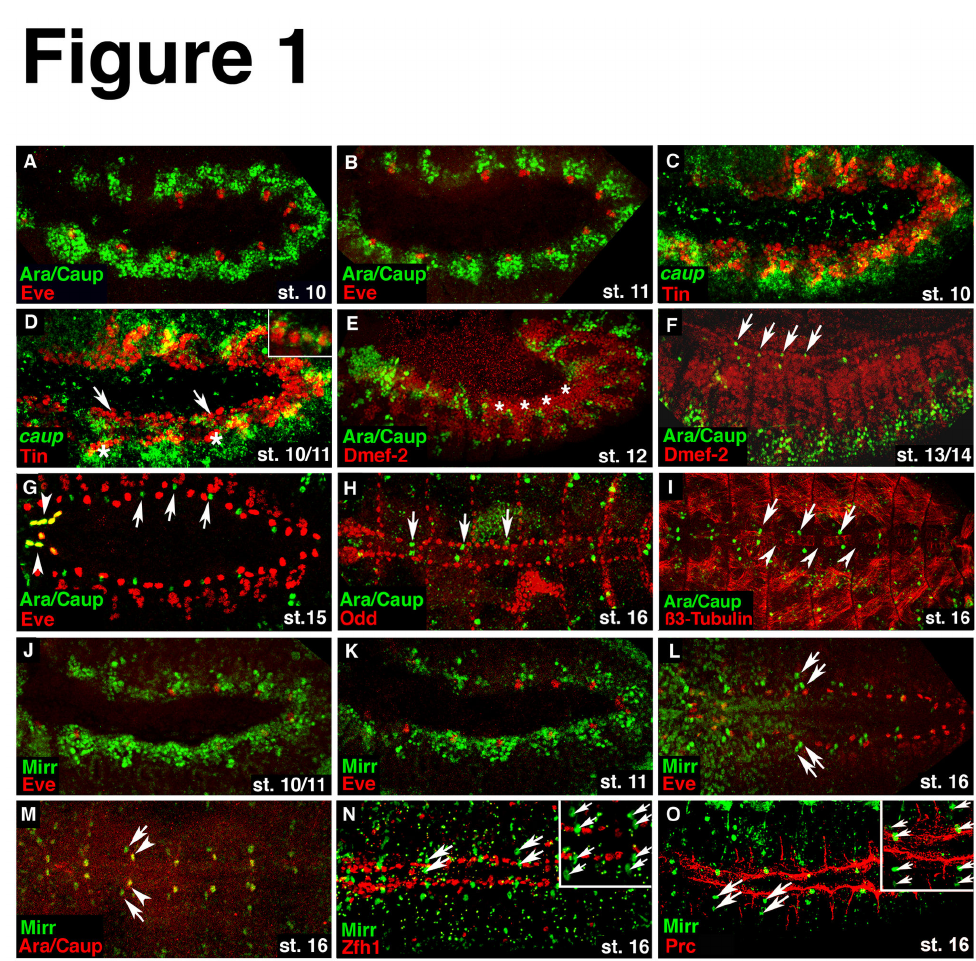
Figure 1. Expression pattern of Ara/Caup and Mirr during embryogenesis in wild-type embryos. (A) Double immunostaining for Ara/Caup and Eve shows the mesodermal expression of Ara/Caup as a continuous band along the dorsal side of the embryo. (B) During stage 11 Ara/Caup proteins are present in segmental clusters abutting the Eve cell clusters. (C) In situ hybridization for caup transcripts and immunostaining for Tin further demonstrates the presence of caup in the dorsal mesoderm. (D) Starting at stage 11 Tin-positive cells segregate into cardiac cells (arrows) and cells of the visceral mesoderm (asterisks). There is still a considerable overlap of Tin and caup mRNA expression. The inset in (D) show a higher magnification to better visualize caup mRNA transcripts around Tin protein that is located in the nucleus. (E) By stage 12 Ara/Caup expression has vanished from the dorsal mesoderm (asterisks) where heart cells begin to differentiate. (F) Starting at mid-embryogenesis, single Ara/Caup-positive cells arise along the Dmef2 expressing myocardial cell row (arrows). (G) Double labeling for Ara/Caup and Eve at stage 15 shows their co-expression in the most anterior Eve-positive pericardial cells (arrowheads), as well as Ara/Caup-only expressing cells located between the Eve pericardial cells (arrows). (H) The Ara/Caup-expressing cells (arrows) are not positive for the pericardial cell marker Odd. (I) β3-Tubulin that labels the four Tin-positive myocardial cells in each hemisegment by stage16 and allows a more accurate localization of the Ara/Caup expressing cells (arrows) along the heart tube. The arrowheads point to the β3-Tubulin- negative myocardial cells in each segment. These cells express Seven-up and Doc. (J) Mirr expression in the dorsal mesoderm is similar to the expression of Ara/Caup at early embryonic stages. (K) During stage 11, Mirr protein accumulates around the Eve- positive cell clusters. (L) At stage 16, pairs of Mirr-only expressing cells are detected between the Eve pericardial cells (arrows). (M) Double labeling for Ara/Caup and Mirr reveals the co-expression of all three factors in one cell (arrowheads) of the segmentally arranged Mirr expressing (arrows) cell pairs. (N) None of the Zfh-1-expressing pericardial cells co-expresses Mirr. (O) Double immunostaining for Mirr (arrows) and the extracellular matrix molecule Pericardin (Prc) that labels pericardial cells and is expressed along the extensions of the alary muscles, shows that the Mirr-positive cells are located between these extensions. Additionally, one of the two Mirr-positive cells lies adjacent to the Prc-expressing basal membrane of the myocardial cells. All embryos are oriented with the anterior to the left. Embryos in A-F, J, K are shown from the lateral side. A dorsal view of the embryos in G, H, I, L-O is shown. doi: 10.1371/journal.pone.0076498.g001 PLOS ONE |